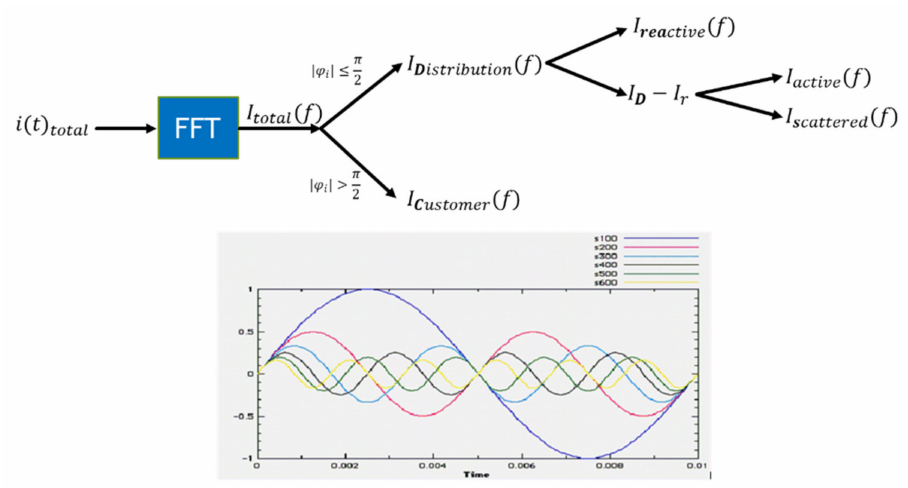
Figure 1. demonstration of extraction of Current’s Physical Components from total current and from current and voltage